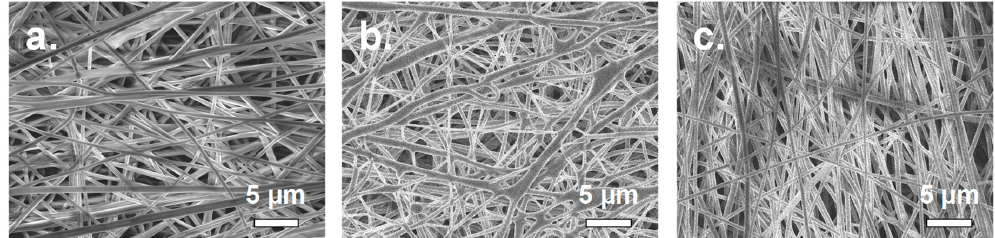
Figure 4. Scanning electron microscopy images of a mixed fiber mat where: ( a ) the inorganic sulfonated silica network was incorporated into the PFSA fibers (Mat Type-A), ( b ) the inorganic network was incorporated into PVDF fibers (Mat Type-B), and ( c ) no inorganic network was added to either fiber type (Mat Type-C).